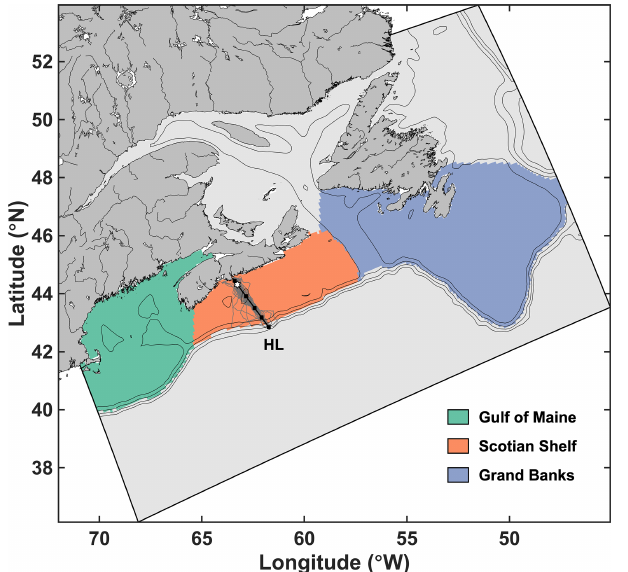
Figure 1. Study area indicating the three averaging zones, the lim- its of the Regional Ocean Modeling System (ROMS) grid and the location of the Halifax Line stations (squares) used in the analysis. The white star is Station 2 and the gray lines are the gliders’ track.